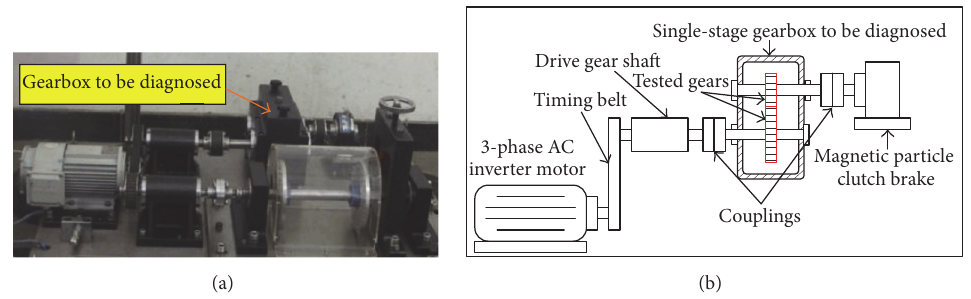
Figure 2: Gearbox fault simulation test setup: (a) overview and (b)